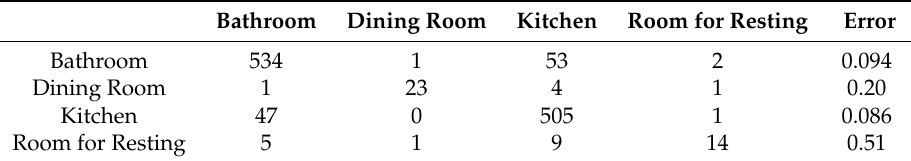
Table 6. Confusion matrix of an RF with 500